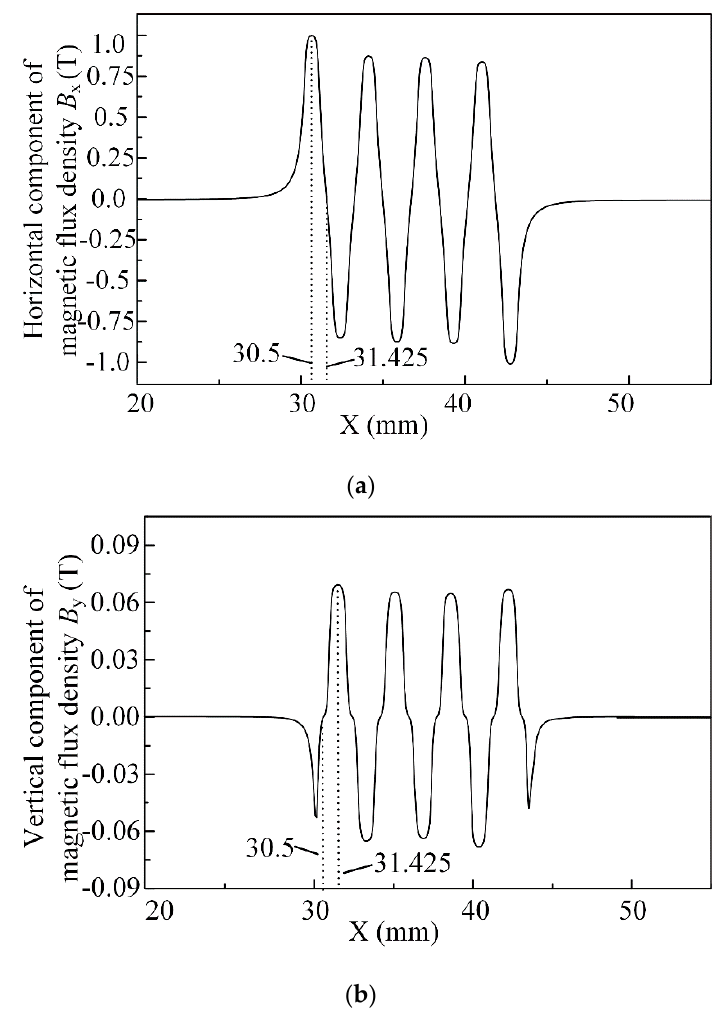
Figure 4. Magnetic flux density in steel plate. ( a ) Horizontal component of magnetic flux density; ( b ) vertical component of magnetic flux density.